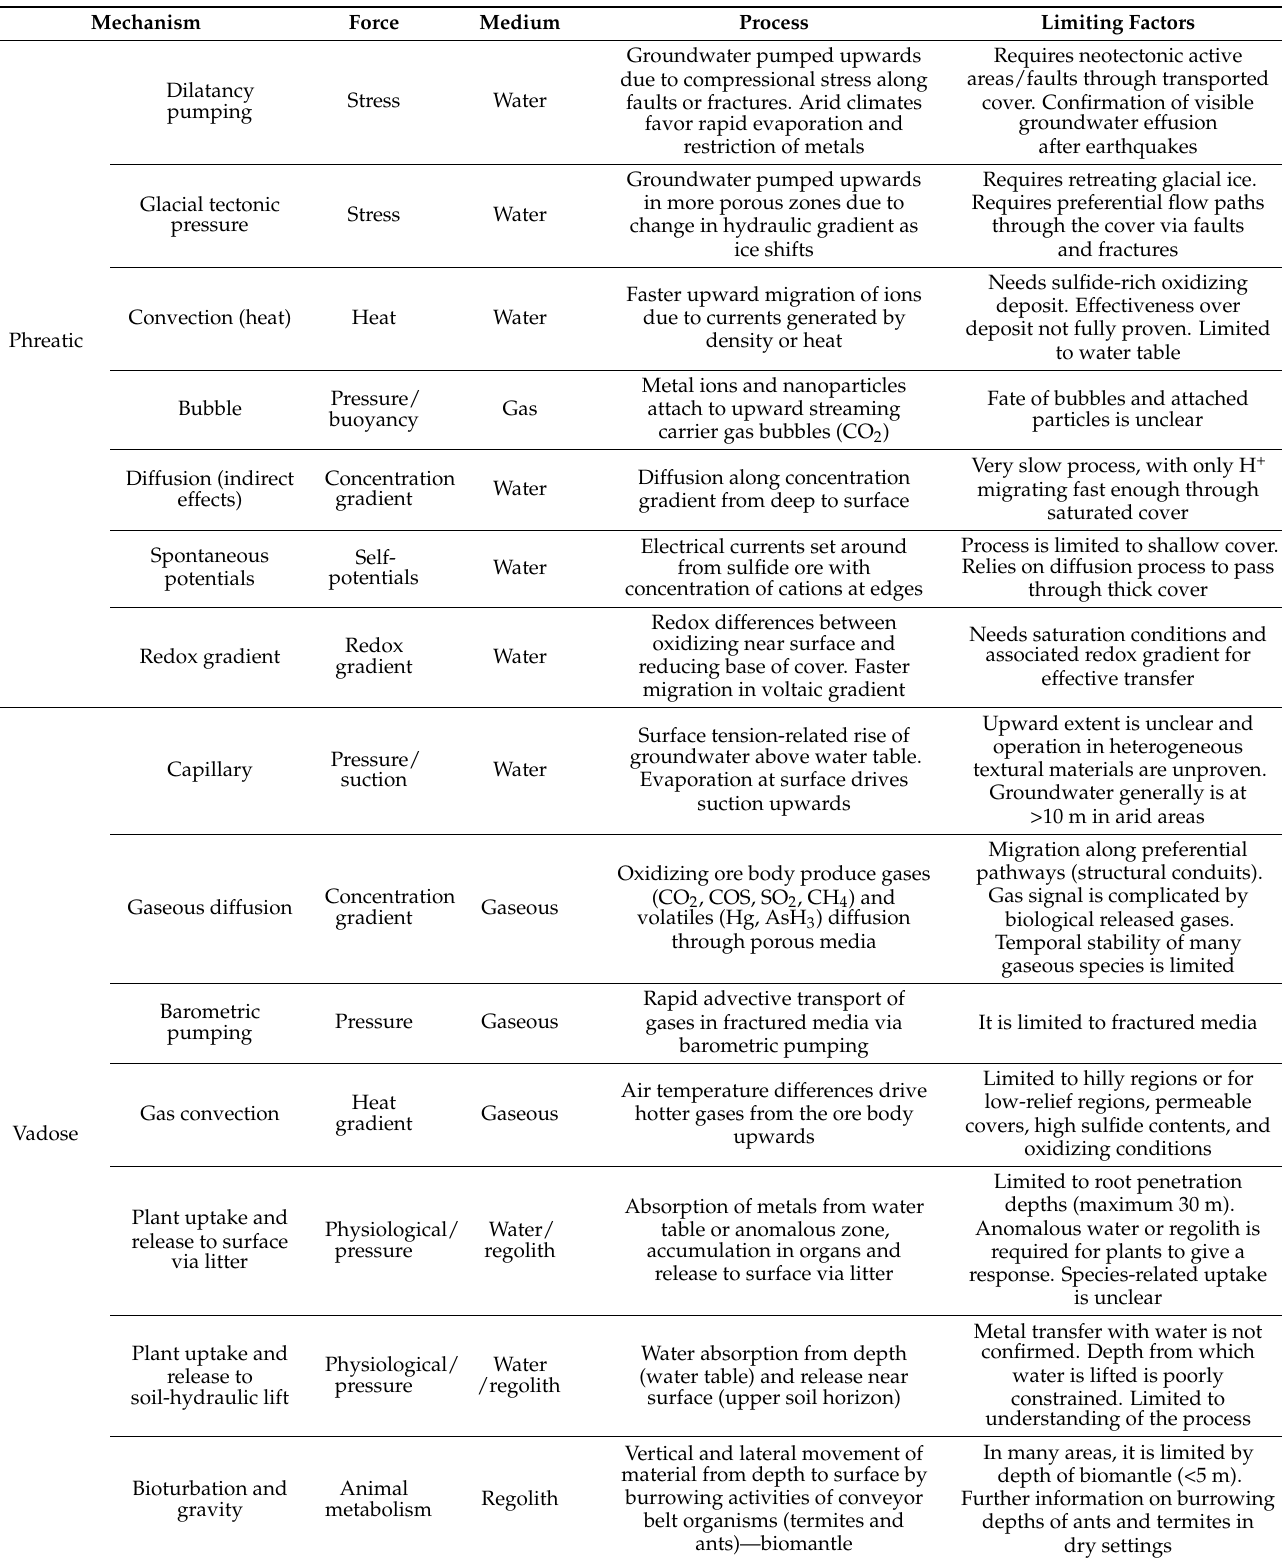
Table 1. Summary of different mechanisms of transfer metals upwards through transported cover (Anand et al., 2016 [40]).